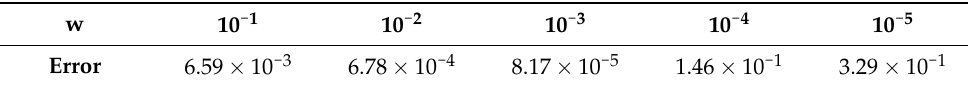
Table 5. The approximation error of the optimal lexicographic point ξ 3 does not monotonically decrease when reducing the scalarization weight w on problem